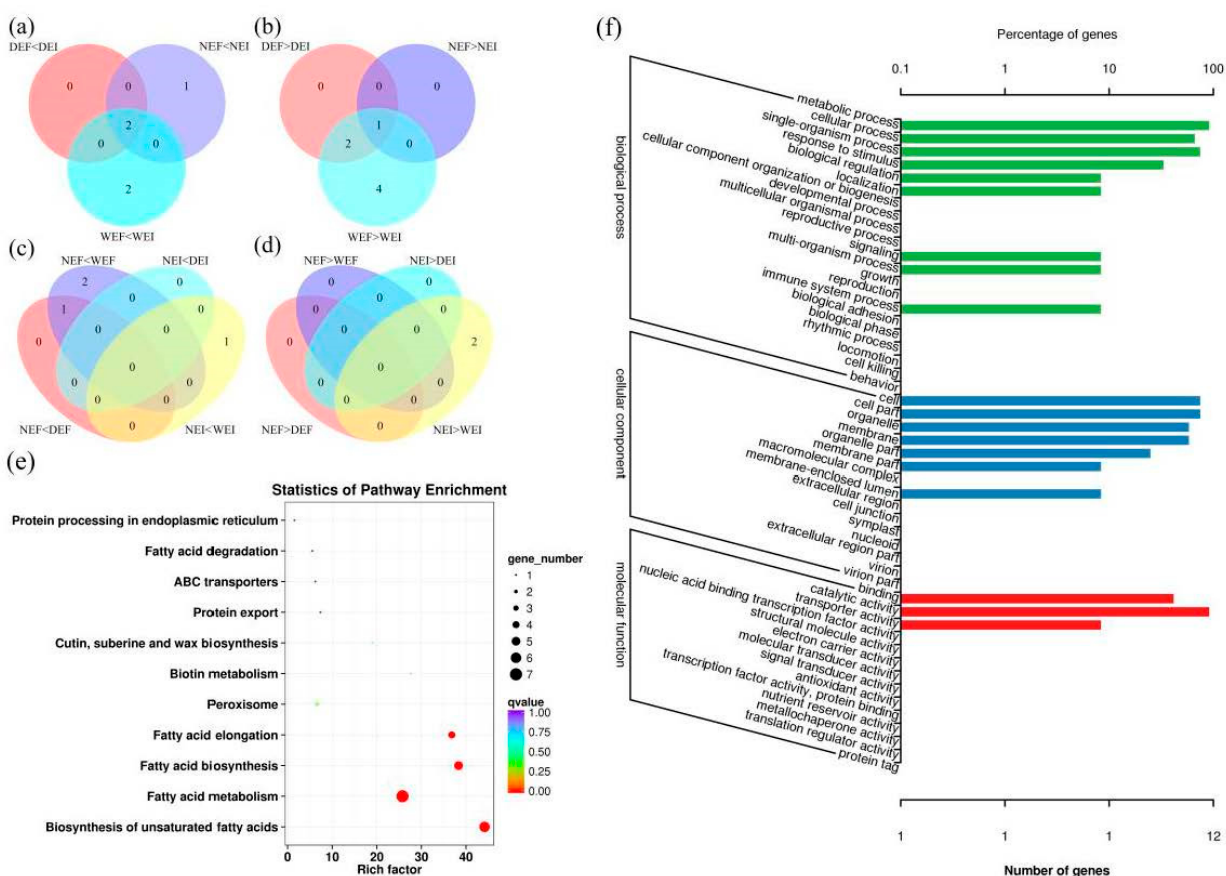
Figure 2. Venn diagrams comparing differentially expressed genes (DEGs) in Achnatherum inebrians under the status of Epichloë gansuensis endophyte ( a , b ) and different moisture content ( c , d ). KEGG pathway enrichment ( e ) of DEGs associated with A. inebrians under different moisture content and the status of Epichloë endophyte. The q-value ranges from 0 to 1, and a q-value closer to 0 indicates greater enrichment. Go class ( f ) of DEGs associated with A. inebrians under different moisture content and the status of Epichloë endophyte (D: drought, N: normal, W: well-watered, EI: endophyte-infected, and EF: endophyte-free).